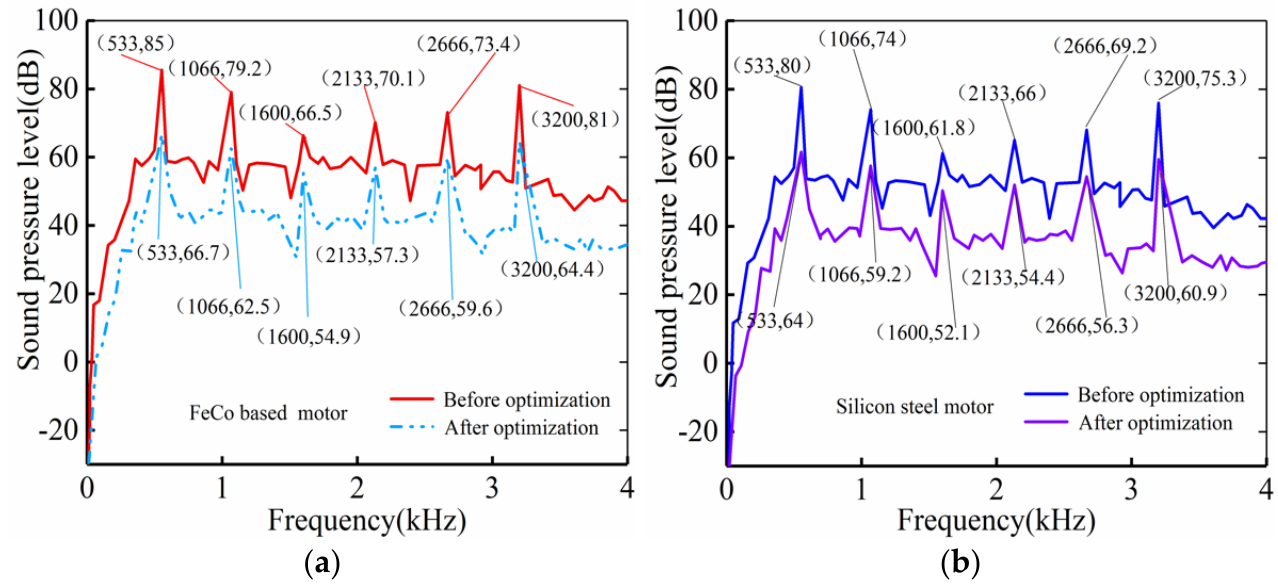
Figure 8. Contrast results of SPL frequency spectrum of FeCo-based motor. ( a ) FeCo-based motor; ( b ) silicon steel motor.